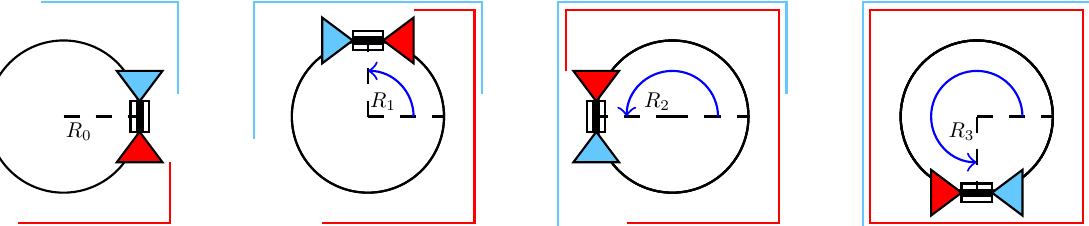
Figure 2. Perception redundancy after a full carrier rotation. The triangles in blue and red show the LiDAR’s frustums in a simplified manner. The lines, also in blue and red, are the measurement in the respective view direction. The figure shows four representative carrier orientations R i ∈ R 3 × 3 , i = 0,1,2,3 with the revolving LiDAR and how its perceptions construct a full scan after a 180 ◦ carrier